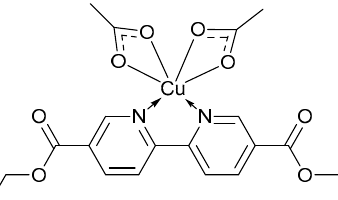
Figure 1. The Cu(BPYDCDE)(OAc) 2 complex for the base-free catalyst system for alcohol oxidation [65]. Reproduced with permission from Han and co-workers. Copyright American Chemical Society, 2018.